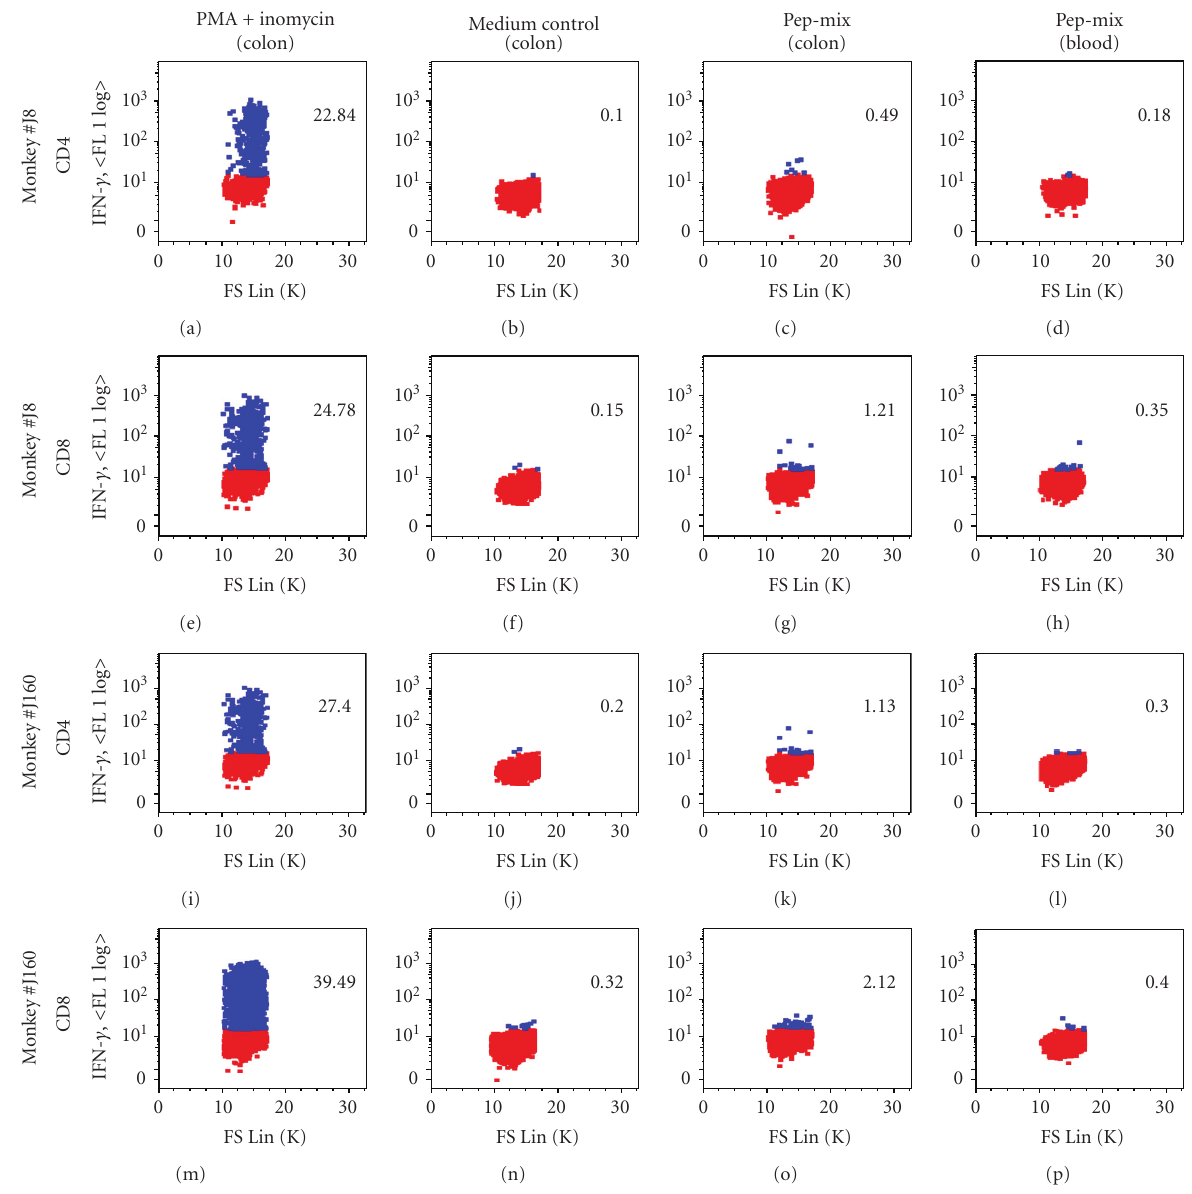
Figure 2: The immunization strategy elicited mucosal long term memory T-cell immune responses. Production of IFN- γ by CD3 + CD4 + or CD3 + CD8 + memory T cells isolated from colon was analyzed in the vaccinated macaques one year after final peptide-cocktail boost. Lamina propria lymphocytes (LPL) from colon biopsy samples were stimulated with peptide-mix or mitogens for 6 h. Both untreated (control) and stimulated cells were stained for surface markers, followed by fixation, permeabilization, and intracellular staining of IFN- γ . Live cells were identified by gating on Aqua-negative cells. The cells gated on CD3 + CD4 + and CD3 + CD8 + were further separated as memory population according to the expression of CD95 (data not shown). The percentage values indicate the population of IFN- γ —producing CD3 + CD95 + CD4 + or CD3 + CD95 + CD8 + lymphocytes.